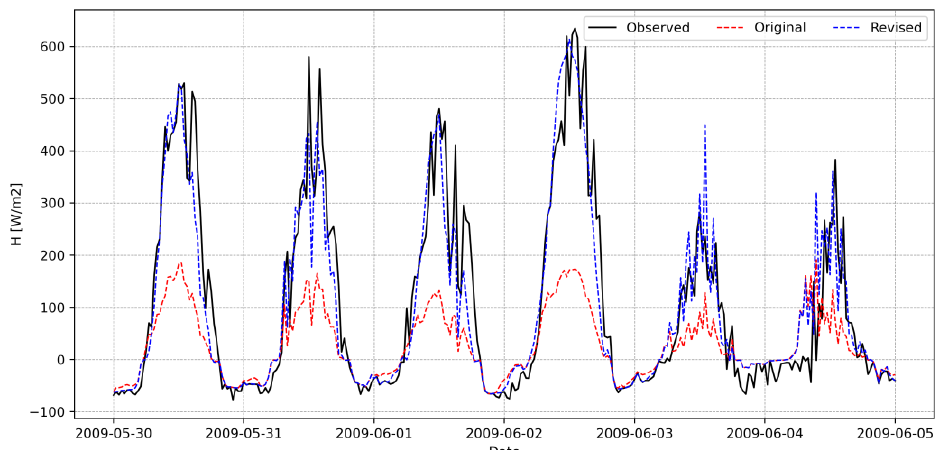
Figure 12. Variations in the observed and simulated sensible heat flux by the original and the revised parameterization at 30 min temporal resolution over five days at the NL-Loo site.